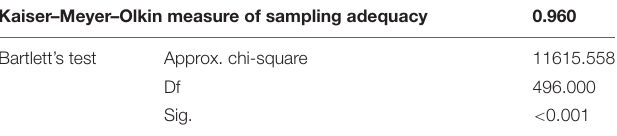
TABLE 4 | KMO and Bartlett’s Test.